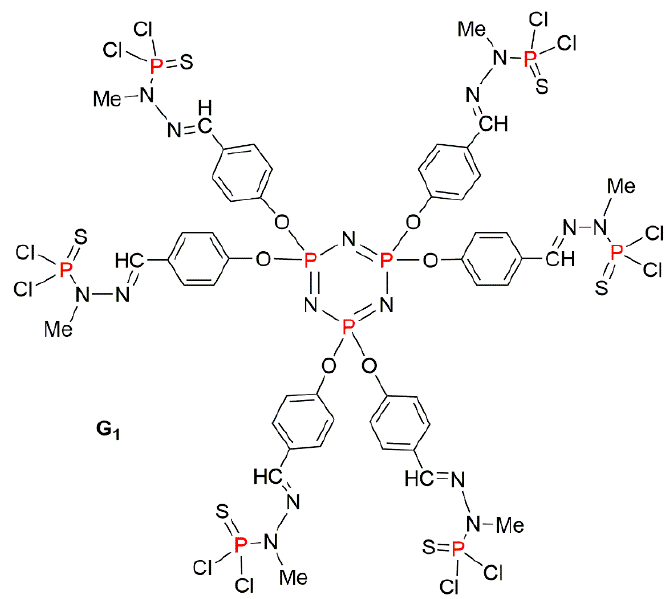
Figure 1. Full structure of the first generation of phosphorhydrazone dendrimer.